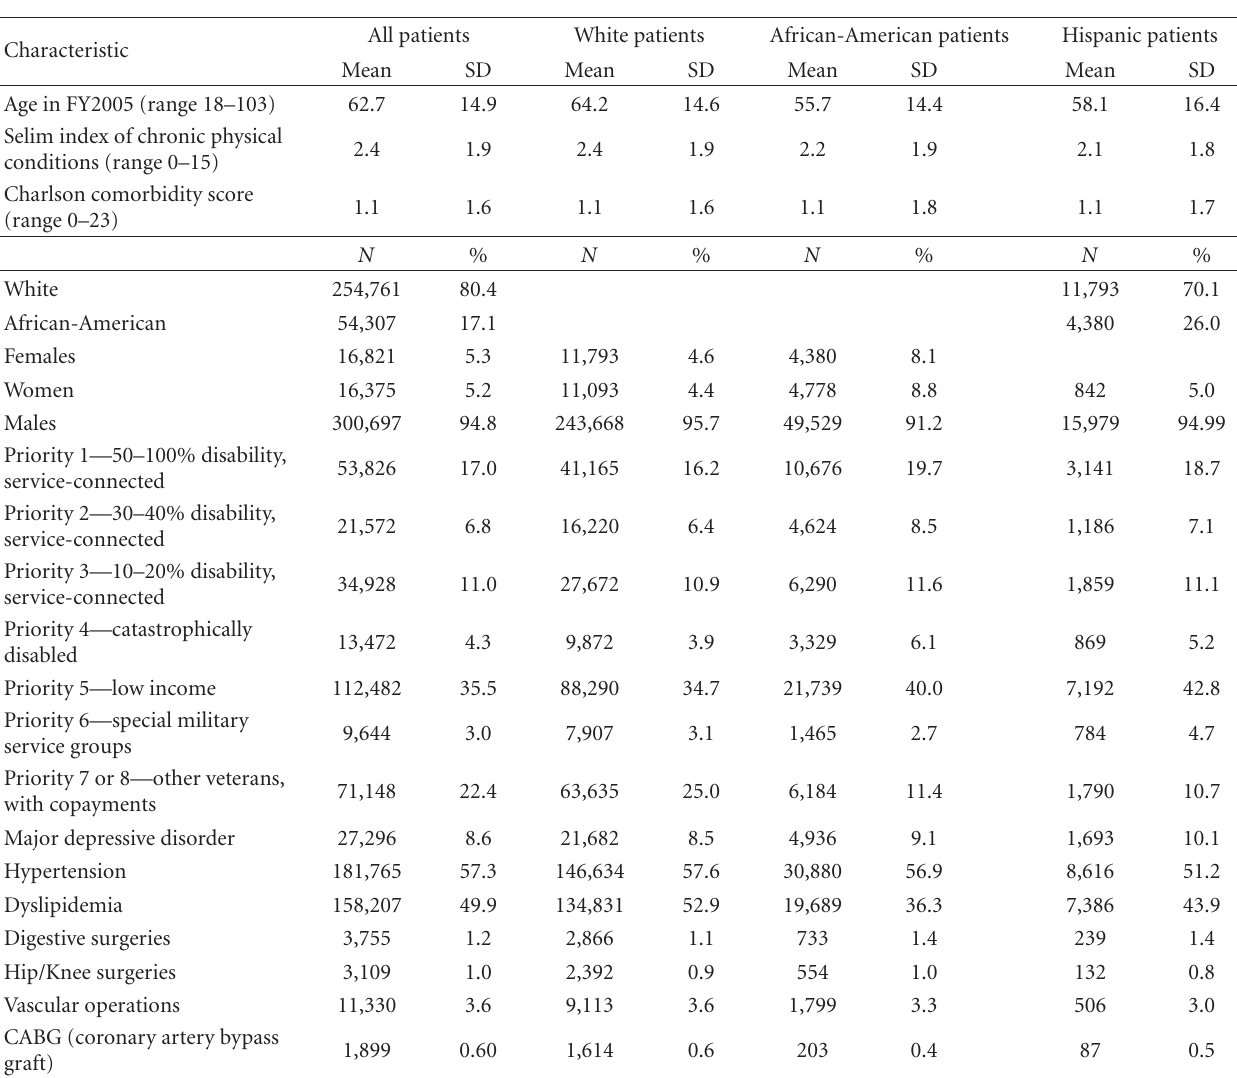
Table 2: Characteristics of VHA patients ( N =